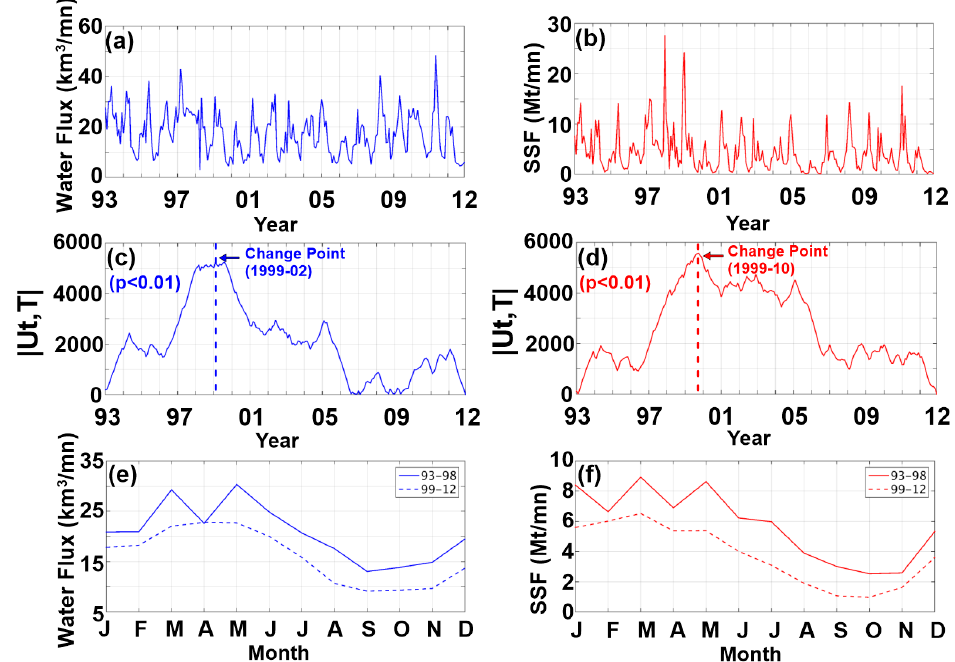
Figure 16. Same as Figure 15 but for the Atchafalaya River.